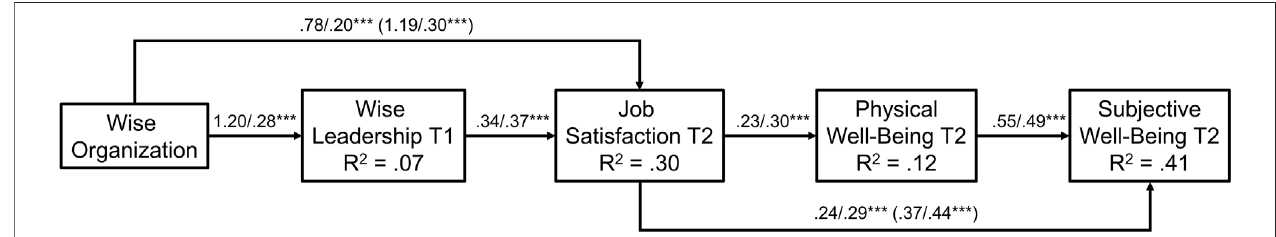
FIGURE 2 | Results of the Path Analysis Model. Note : n (cid:1) 821; WLS estimation using LISREL 9.30; unstandardized/standardized coef fi cient estimates controlling for supervisor position, gender, race, age,and education level;standard errors, t -values, and χ 2 statisticscorrected for non-normality. Unmediated direct effects ofwise organization on job satisfaction and job satisfaction on subjective well-being in parentheses. WLS χ 2 (cid:1) 2.97 ( p (cid:1) 0.56, df (cid:1) 4); GFI (cid:1) 0.92, CFI (cid:1) 1.00, IFI (cid:1) 1.00, RMSEA (cid:1) 0; p for RMSEA < 0.05 (cid:1) 0.97; CN (cid:1) 3,671.34. *** t -value > 3.29 ( p < 0.001).